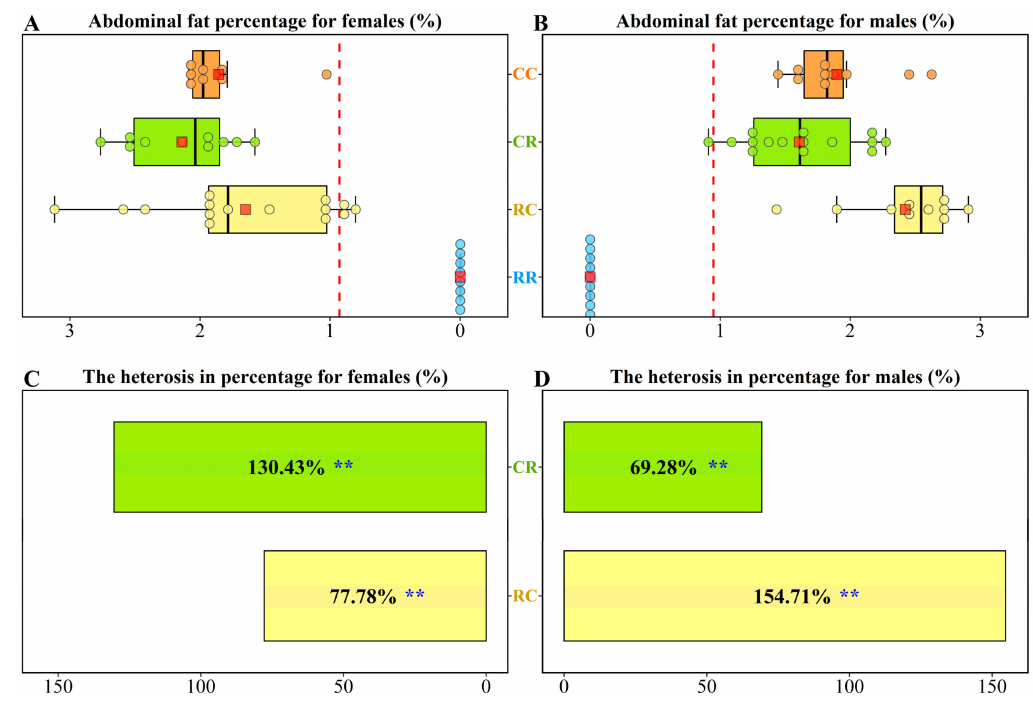
Figure 1. Boxplots for the abdominal fat percentages of the four groups: ( A ) females, ( B ) males. Orange, green, yellow, and blue boxes represent the CC, CR, RC, and RR groups, respectively. Each dot represents an individual. The central red point in each box represents the average value in the corresponding group. The red dashed line represents the average of the two parental lines (termed the mid-parent value). Heterosis of abdominal fat percentages for reciprocal crosses: ( C ) females, ( D ) males. Green and yellow boxes represent the CR and RC groups, respectively. The values of heterosis for the CR and RC groups are presented in the corresponding boxes. Significance was analyzed by Student’s t-test and ** indicates that p -value is <